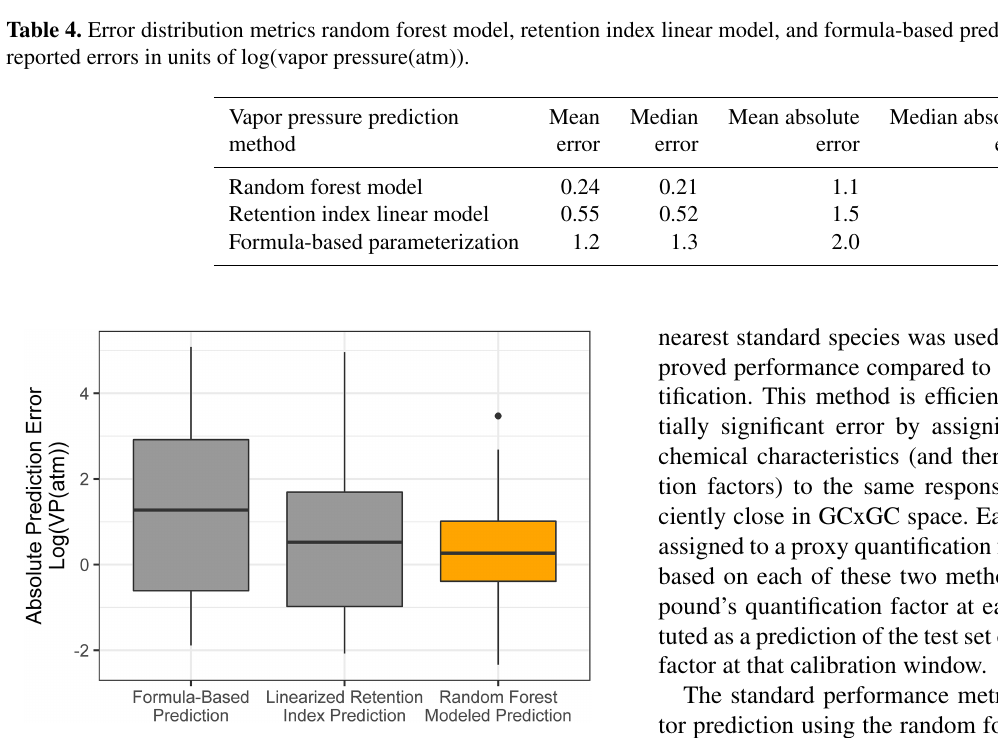
Figure 6. Vapor pressure prediction residuals (log(vapor pressure); vapor pressure in the atmosphere) for vapor pressure predictions of the ambient extrapolation set based on formula-based parameteri- zation (Li et al., 2016), linearized retention index-based modeling, and random forest